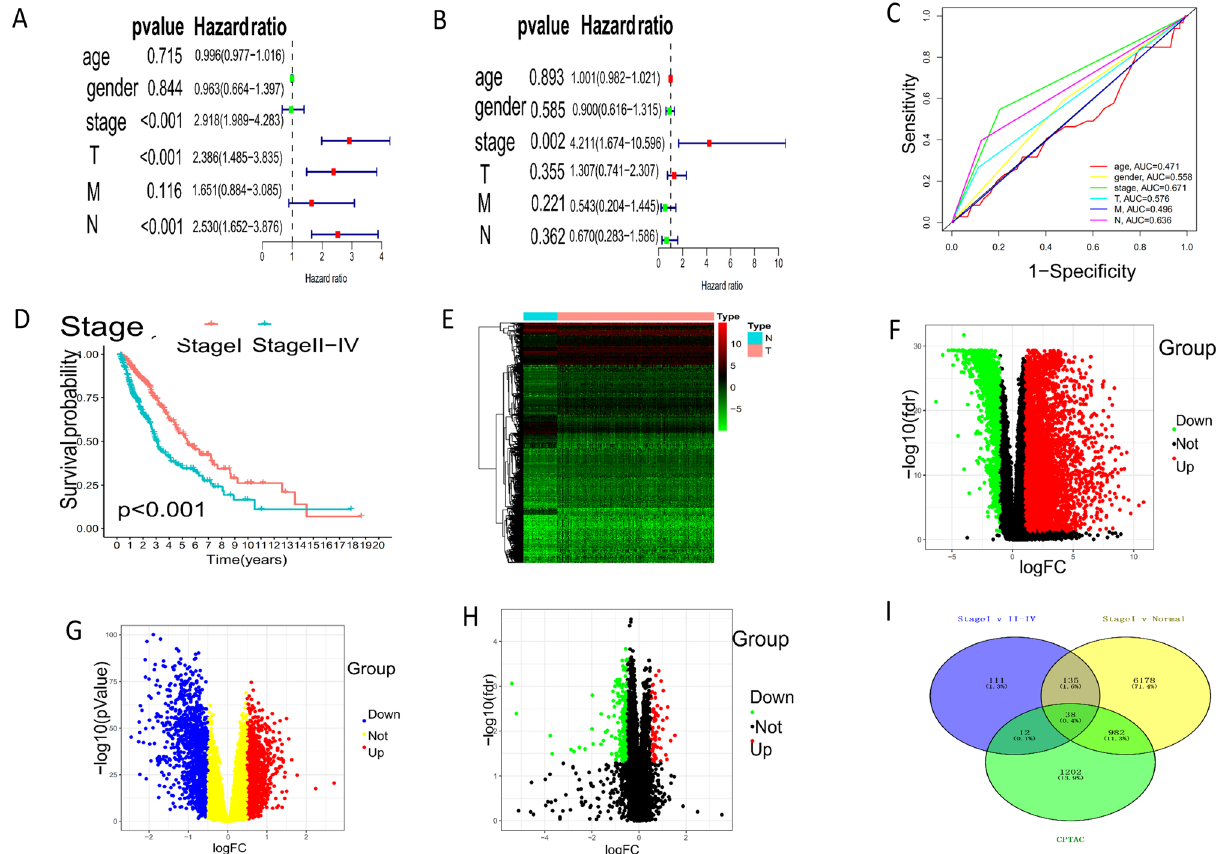
Figure 1. Screening early diagnostic genes related to TMNStage. ( A , B ), Forest plots showed univariate ( A ) and multivariate Cox ( B ) analysis of clinical characteristics. ( C ) ROC curve plots of clinical features. ( D ) Survival analysis between stage I and stage II-IV groups. ( E , F ) Heat, and ( F ) volcano map of differentially expressed genes between StageI and normal groups from the TCGA database. ( G ) Based on the Cptac database, the heat map showed the differentially expressed proteins between the normal and tumor group. ( H ) Based on the TCGA database, Heatmap showed the differentially expressed genes between StageI and II-IV. ( I ) Wayne’s diagram indicates that early diagnosis genes are screened via the overlaps of differential genes of the three